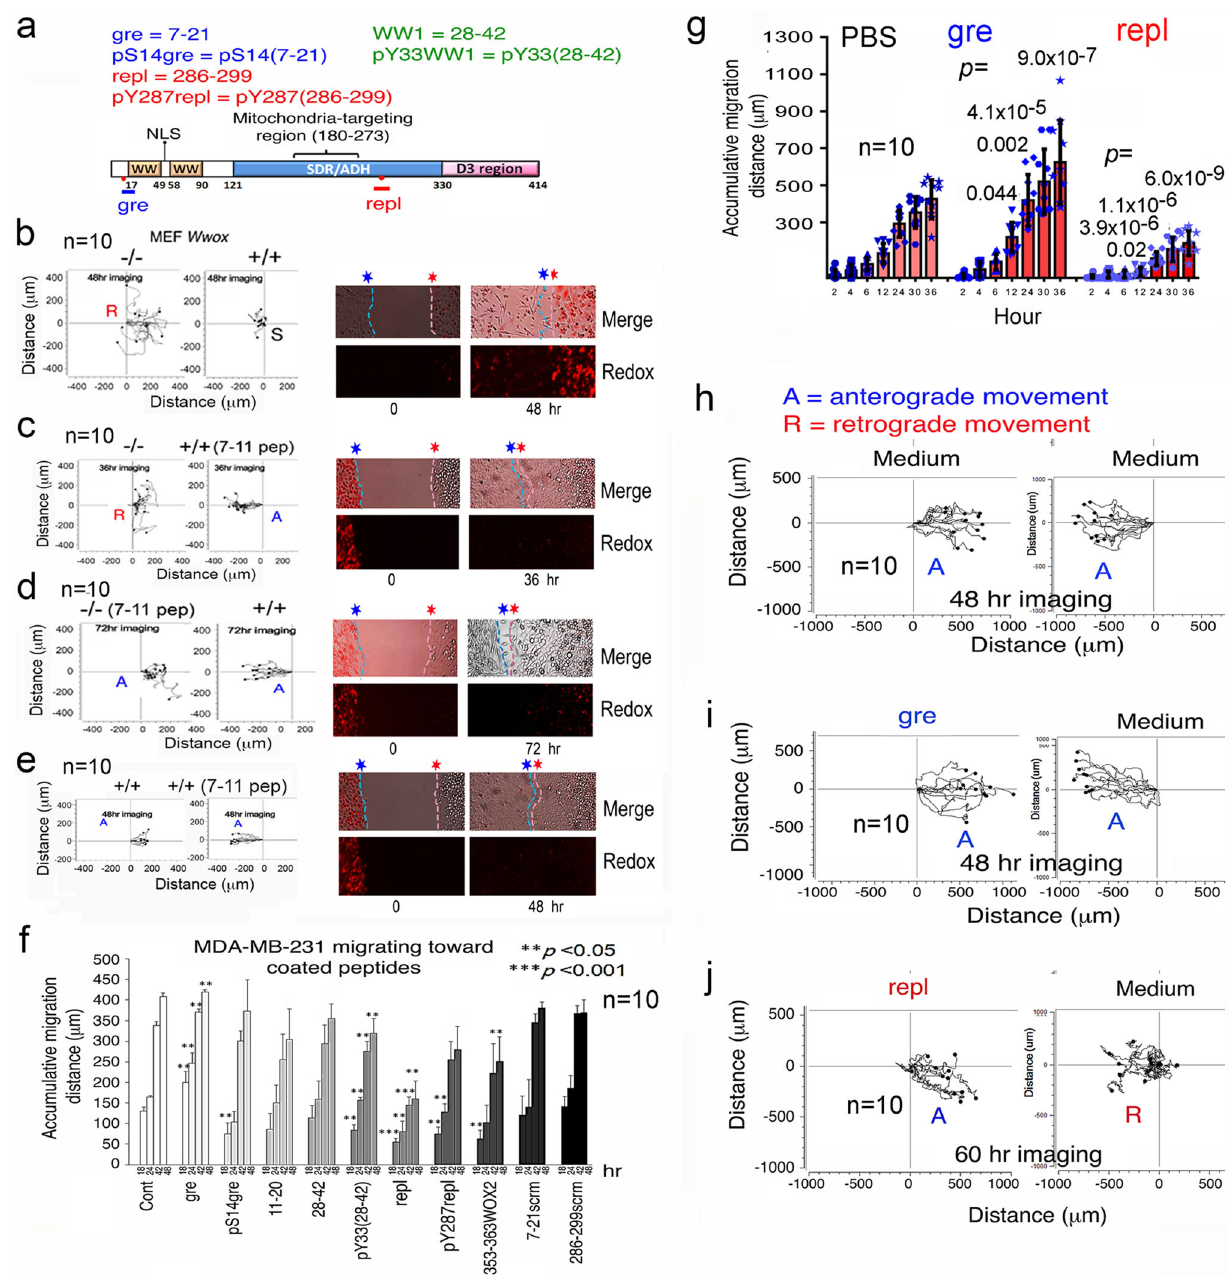
Fig. 5 Gre (WWOX7-21) peptide enhances cell migration whereas repl (WWOX286-299) peptide retards cell migration. a The primary structure of WWOX and localization of synthetic peptides are shown. b – e WWOX7-11 (10 μ M) or PBS control was added to one of the MEF wild type versus MEF Wwox knockout cell pair for migration by time-lapse microscopy. The redox sensor CC1 was added to the cells at the left chamber, followed by starting the assay. Knockout cells induced redox activity in the wild type cells ( b ), as determined by CC1 incorporation. The induction was blocked by WWOX7-11 peptide when either the wild type or knockout cells received the peptide treatment. f One chamber of the culture-insert (ibidi) was coated with 200 μ M (~15 ng) gre or repl peptide (or conjugation buffer only) overnight prior to washing, and the other side seeded with cells. Migration of MDA-MB-231 cells to each indicated peptide was carried out. Accumulative travel distance with time is shown. g MDA-MB-231 cells were seeded in the left chamber and pretreated with gre or repl peptide (20 μ M) for 4 hr at 37 °C, followed by washing to remove the peptides. Untreated control cells were seeded at the right chamber. The accumulative distance of cell migration with time is shown. h – j Similarly, by time-lapse microscopy, gre peptide-treated MDA-MB-231 cells enhanced the migration of untreated control cells leading to merge. In contrast, repl peptide-treated MDA-MB-231 cells induced retrograde migration of the control cells. Tracking the migration of 10 randomly selected cells is shown. (Fig. 6b; also see Fig. 6b_statistics in the section C of Supple- which is associated with WWOX degradation via ubiquitination mentary Figures of Supplementary Information). Non-immune and proteasome 44 . To validate the antibody speci fi city, we carried out peptide serum and antiserum against pY287repl had no neutralizing blocking for the produced antisera 28 . Pre-incubation of gre effects (Fig. 6b). Tyr287 is a conserved phosphorylation site, COMMUNICATIONS BIOLOGY| (2021) 4:753